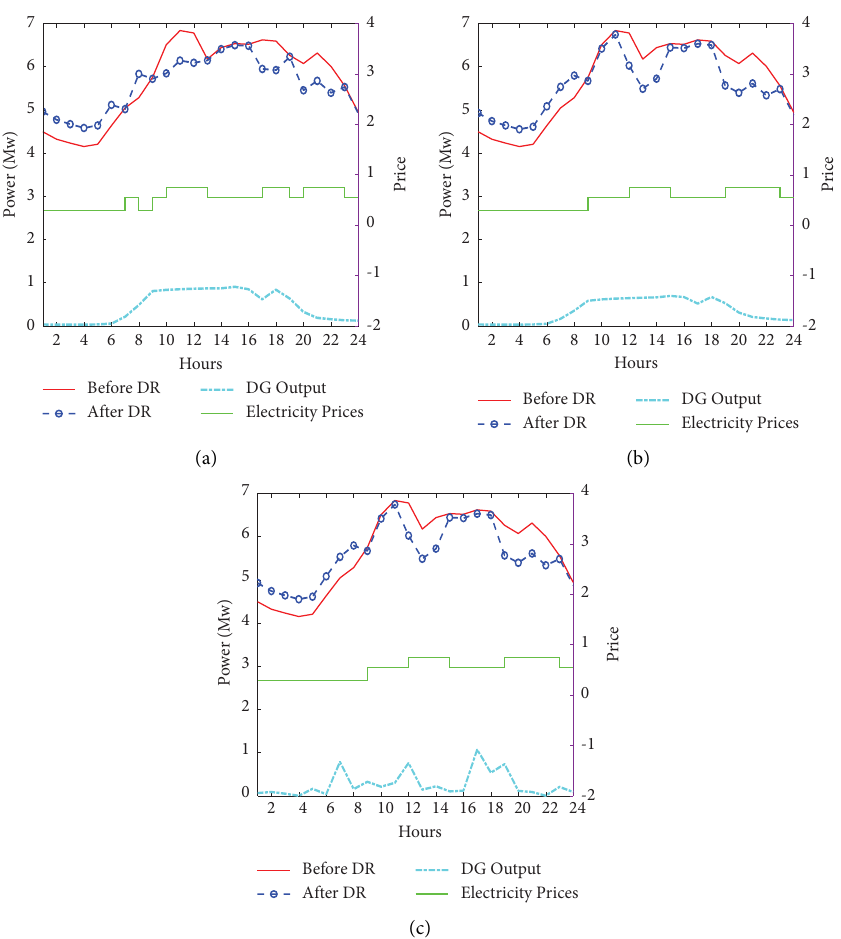
Figure 10: Load and electricity price changes of the three schemes in the scenario with large peak-valley diference. (a) Scheme 1. (b) Scheme 2. (c) Scheme